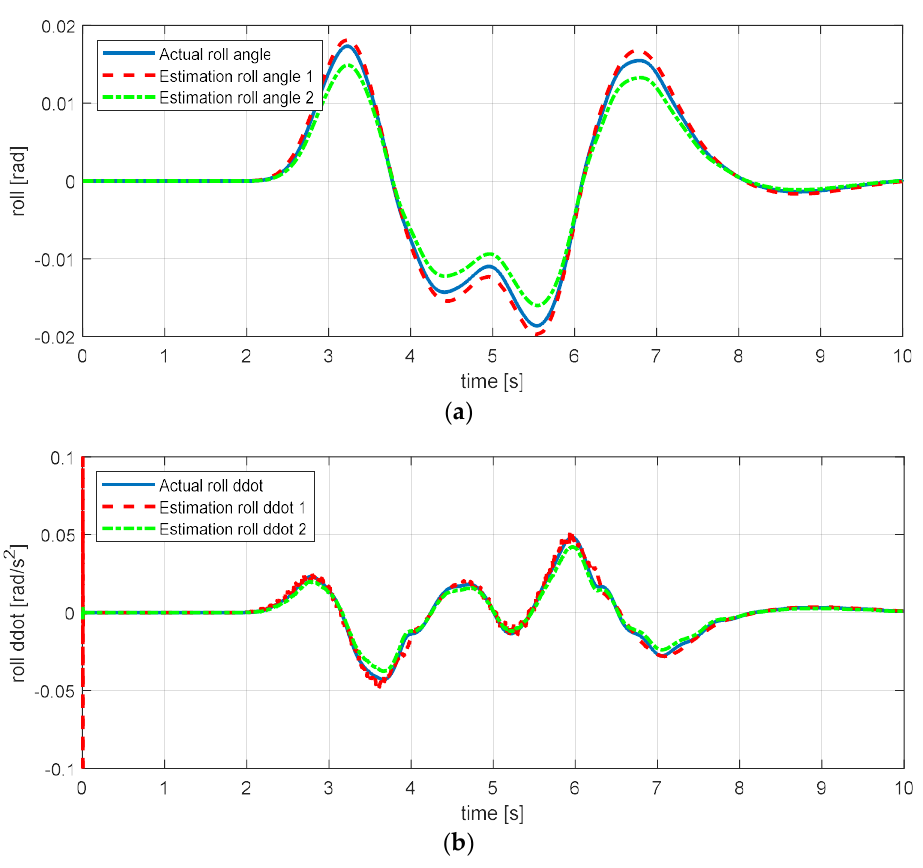
Figure 15. Estimation simulation result for the roll angle derivative of the roll rate. ( a ) Roll angle; ( b ) a derivative of the roll rate.